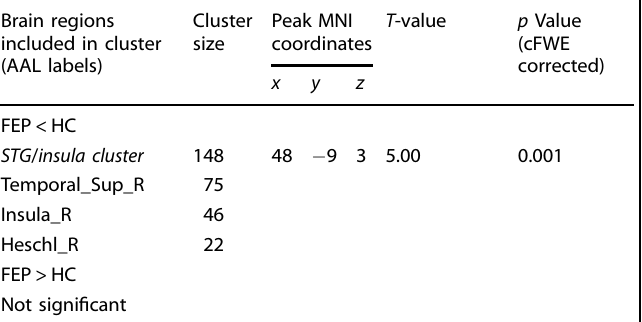
Table 2. Brain regions showing reduced centrality in the FEP ( n = 38) group compared to HCs ( n =